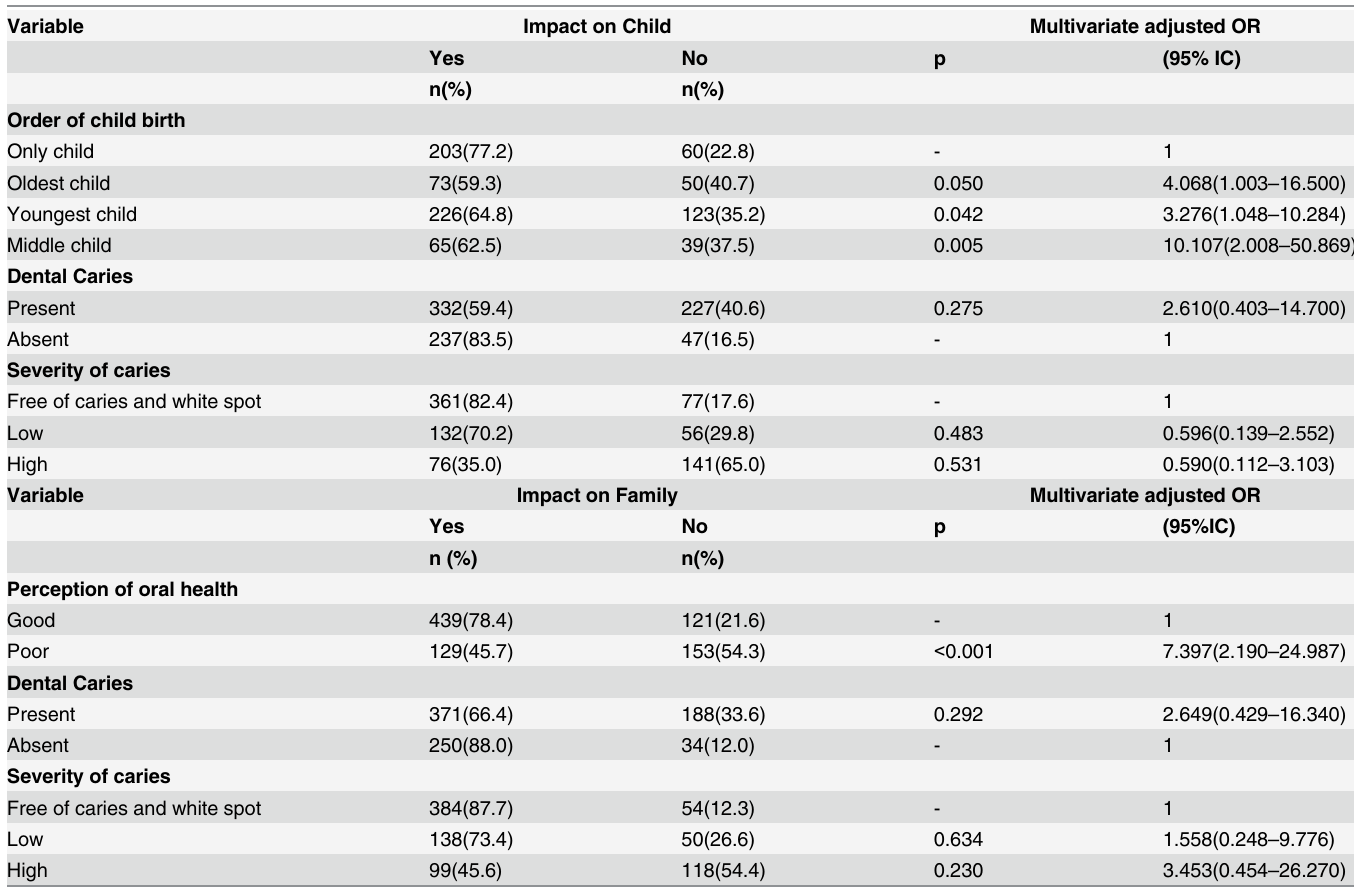
Table 4. Multivariate logistic regression models for the impact of dental caries in the quality of life of pre-school children, their families and the independent